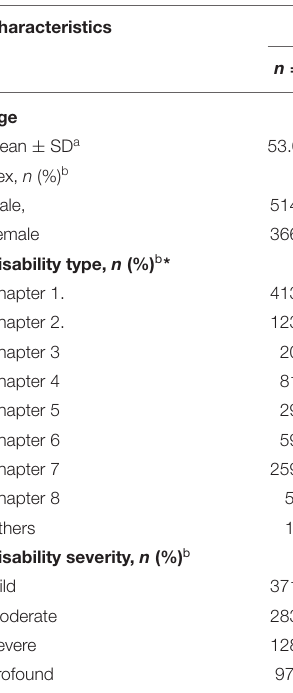
TABLE 1 | Demographic data of the study